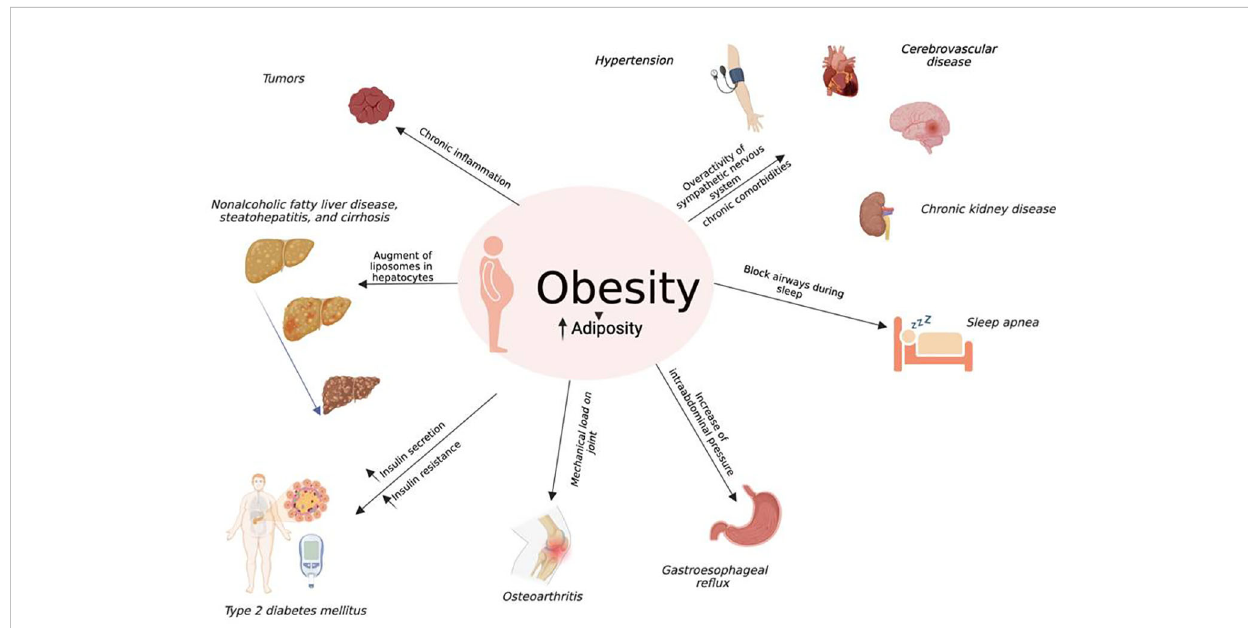
FIGURE 1 Obesity and co-morbidities: Obesity is distinguished by excess adiposity distributed to many body compartments. The increase of adiposity in pharyngeal soft tissue causes blocked airways during sleep, triggering obstructive sleep apnea; moreover, it causes both osteoarthritis, due to increased mechanical loading on the joints, and gastroesophageal re fl ux disease, due to an increase in intra-abdominal pressure. The obesity-related proin fl ammatory state with an increase in cytokines prompts insulin resistance, and together with insulin secretion that increases linearly with the BMI, supports dyslipidemia and T2DM. This obesity-induced chronic in fl ammation plays an endorsing role in cancer progression due to its promotion of a permissive microenvironment for neoplastic transformation. Furthermore, liposomes augment in hepatocytes that evolve in non- alcoholic fatty liver disease, steatohepatitis, and cirrhosis. Another consequence of obesity is chronic overactivity of the sympathetic nervous system that, together with the previously described consequences of chronic obesity, induces hypertension and increases the risk of heart disease, stroke, and chronic kidney